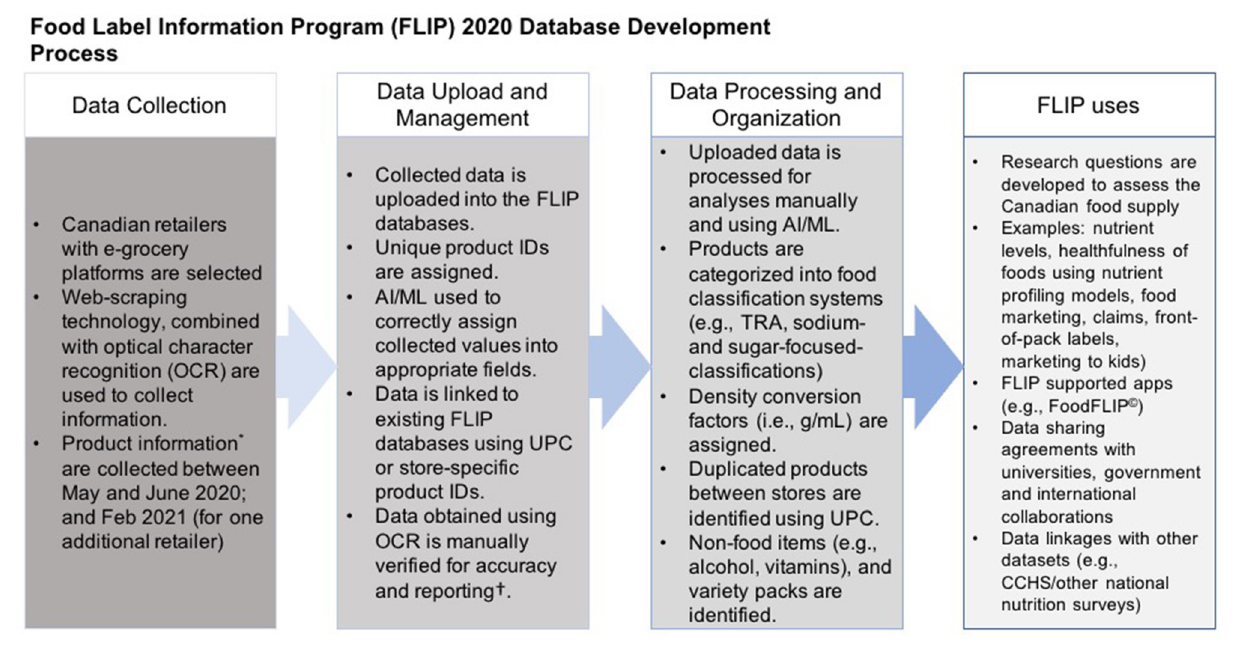
development and enhancements; Phase 2, data capture and management of food products and nutrition information (i.e., Nutrition Facts table (NFt); Phase 3, data processing and food categorization ( Figure 1